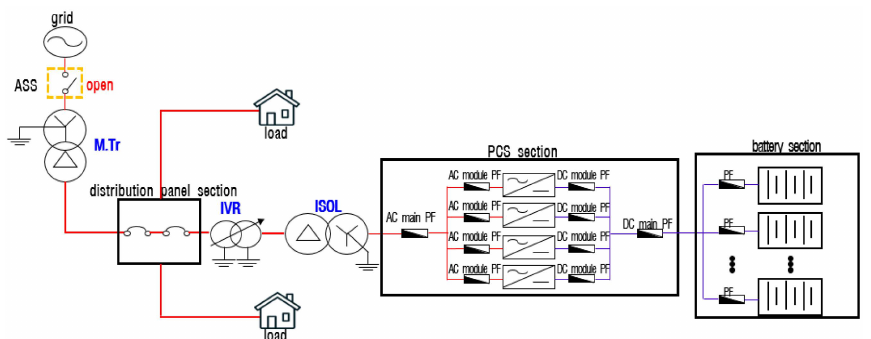
Figure 1. ASS open due to short-circuit fault on ESS DC side.